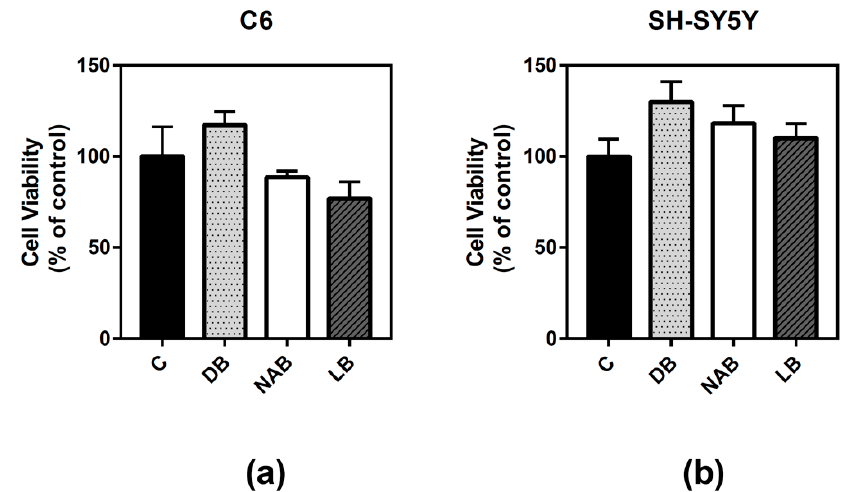
Figure 1. E ff ect of di ff erent beer extracts on C6 and SH-SY5Y cell viability. Dark beer (DB), non-alcoholic beer (NAB), and lager beer (LB) extracts were added to C6 ( a ) and SH-SY5Y ( b ) cells for 24 h. Data are means ± SEM of, at least, three independent assays. Di ff erences were not statistically significant according to Student’s t test or one-way ANOVA.